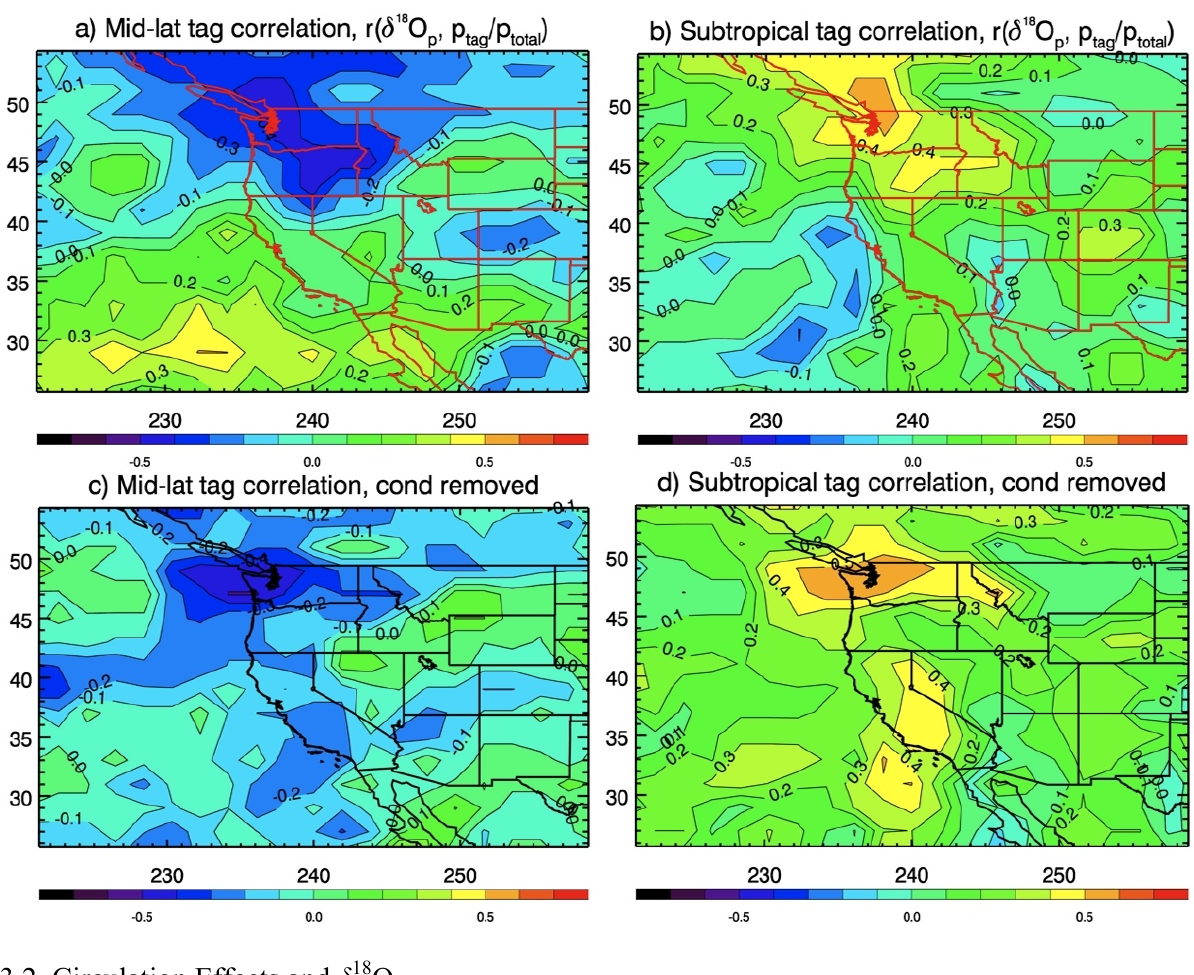
Figure 10. ( a ) Correlation between interannual δ 18 O variations and the fraction of p precipitation from middle latitude tags; and ( b ) subtropical tags; Panels ( c ) and ( d ) show the same correlations, as ( a ) and ( b ) (respectively), but with the influence of post-condensation exchanges and condensation height removed. Contour intervals are 0.1. Absolute values of r above 0.263 are significant above the 95% confidence